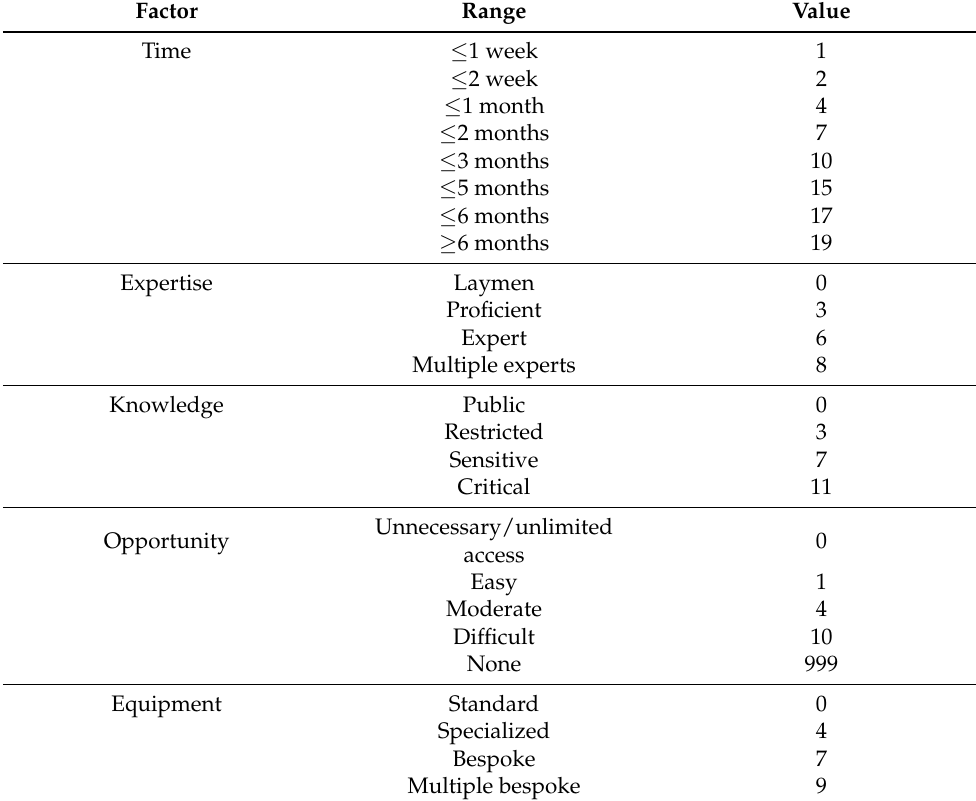
Table 6. Factor and